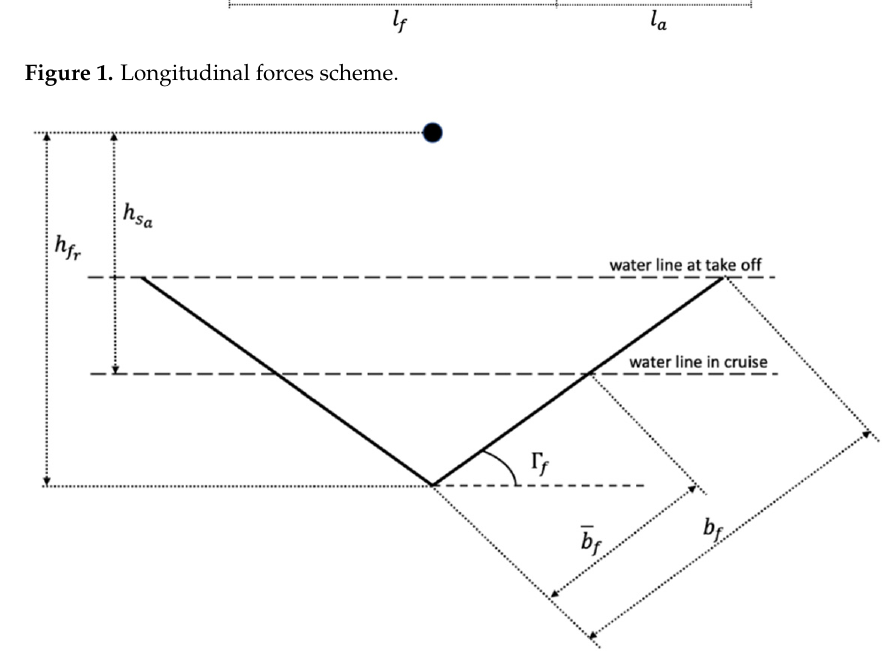
Figure 2. Forward hydrofoil immersion characteristics.